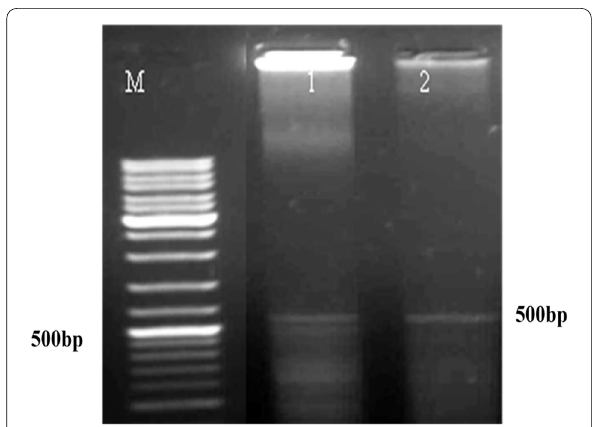
Fig. 3 M, marker, DNA samples amplified with ApCoc4 primer in replicates (amplicon size ~ 500 bp) in L1 and